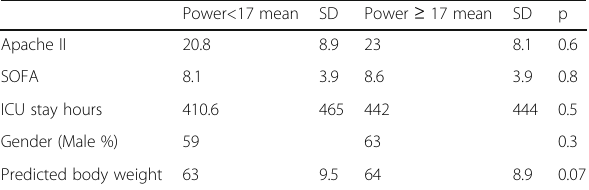
Table 3 (abstract 001529).